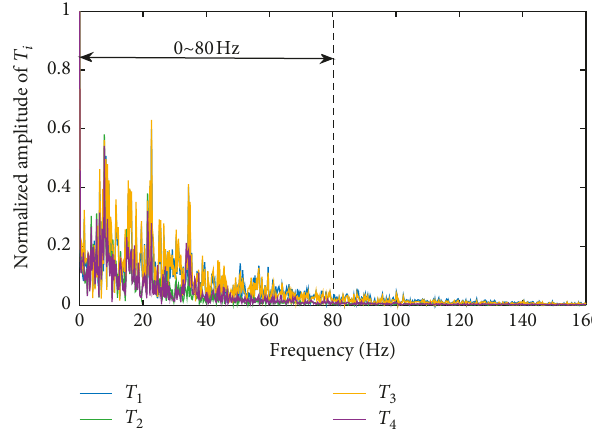
Figure 9: FFT of T i without considering the inertial constraint in the